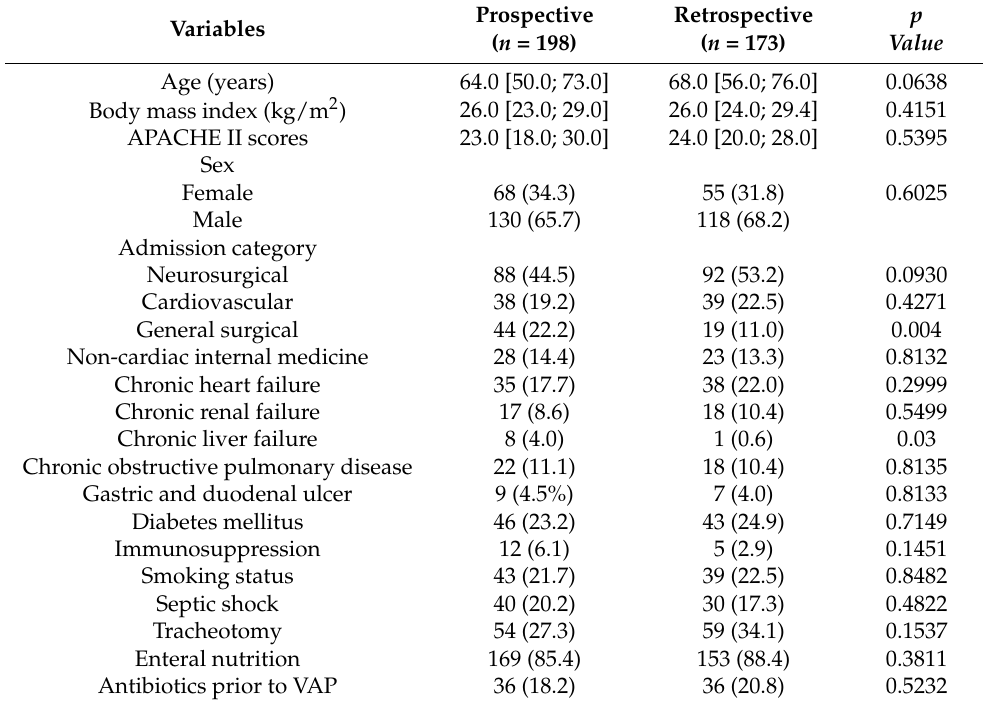
Table 2. Patient